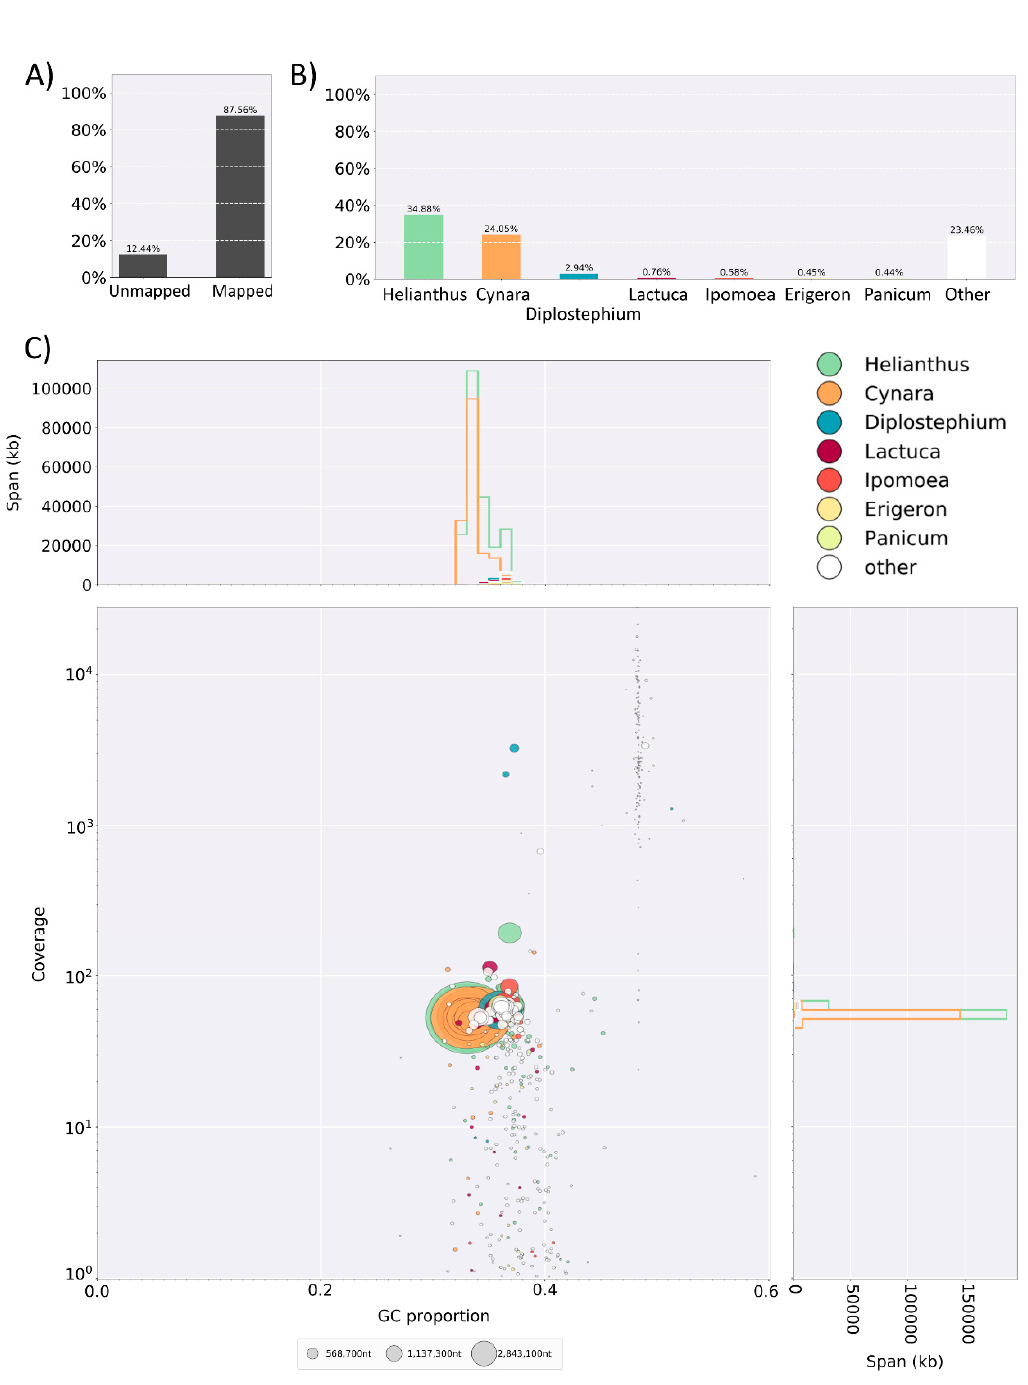
Figure 2. Blobplot generated for Conzya canadensis (Asteraceae) draft genome assembly showing the genera with the closest similarity to the sequenced genome (Laforest, Martin, and Page unpublished data). The first panel ( A ) indicates the percentage of reads that were mapped and the second panel ( B ) shows the taxonomic break down of hits at the taxonomic level requested. In this case the majority of hits are from other genera from the Asteraceae. The program generates a text file with more detailed information. The three part third panel ( C ) shows histograms for the proportion of G and C bases in the sequence which typically varies among species (top) and coverage (right) weighted by the cumulative length of sequences in each bin. The main panel has circles colored by taxonomic affiliation positioned on the x-axis by the GC proportion and on the y-axis by coverage within the raw data which gives a sense of the relative concentration of the sequences in the DNA sample.